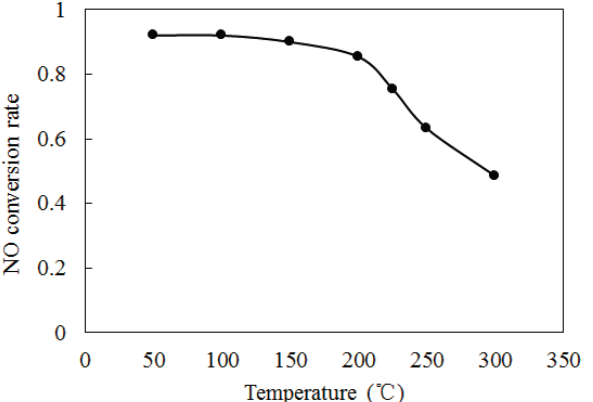
Figure 7. Variations of NO conversion rate with temperatures at O 3 /NO concentration equals 1.0.